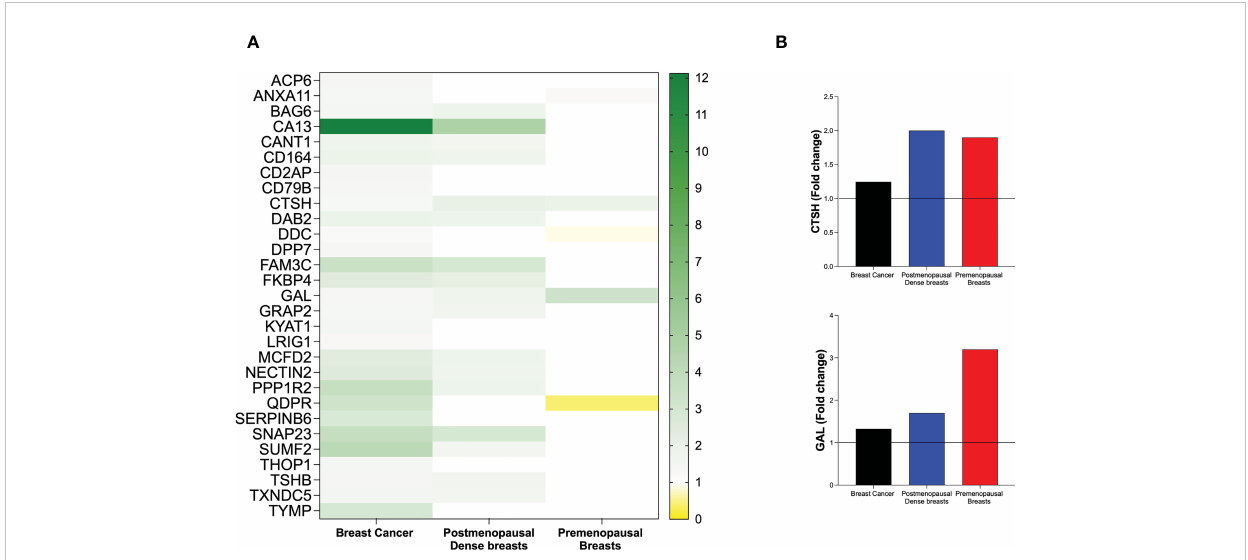
FIGURE 5 Heat map of extracellular in vivo metabolic proteins that were identi fi ed as signi fi cantly altered in human breast cancer. Microdialysis was performed for in vivo collection of proteins from the extracellular space that were quanti fi ed in as described in the Materials and Methods in three cohorts of women; 12 with ER+ breast cancer, 40 postmenopausal healthy women with dense (n=20) or nondense (n=20) breast tissue, and 19 premenopausal women investigated in the luteal phase of the menstrual cycle. (A) Left column depicts all 29 proteins that were identi fi ed as up-regulated in human estrogen receptor positive breast cancer patients as compared to normal adjacent breast tissue. Mid column depicts the regulation of the proteins in postmenopausal dense breast tissue vs. postmenopausal nondense breast. Right column depicts the regulation of the proteins in premenopausal breast tissue vs. postmenopausal dense breast tissue. (B) Fold change of the only two proteins that were similarly regulated in the three cohorts: Pro-cathepsin H (CTSH) and Galanin peptides (GAL).